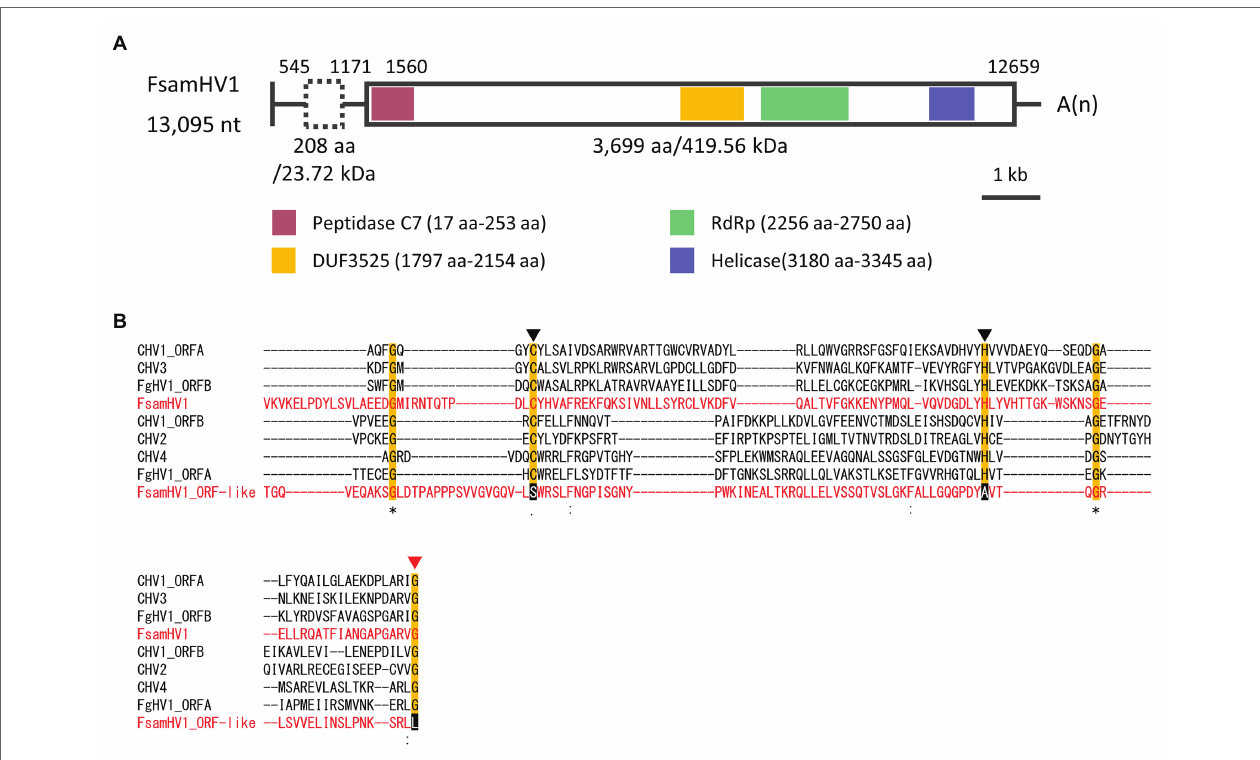
FIGURE 4 | Genomic properties of FsamHV1. (A) Schematic representation of the complete genome of FsamHV. Open box with solid line, predicted ORF; open box with dashed line, putative ORF with GUG as a start codon; red box, conserved peptidase domain; yellow box, DUF3525 domain with unknown function; green box, conserved RNA-dependent RNA polymerase (RdRp) domain; and blue box, conserved helicase domain. (B) Amino acid (aa) sequence alignment of the region corresponding to the peptidase domain. Amino acid residues, which are required for the autoproteolytic activity, are indicated by black triangles, and an amino acid residue of the putative cleavage site is indicated by a red